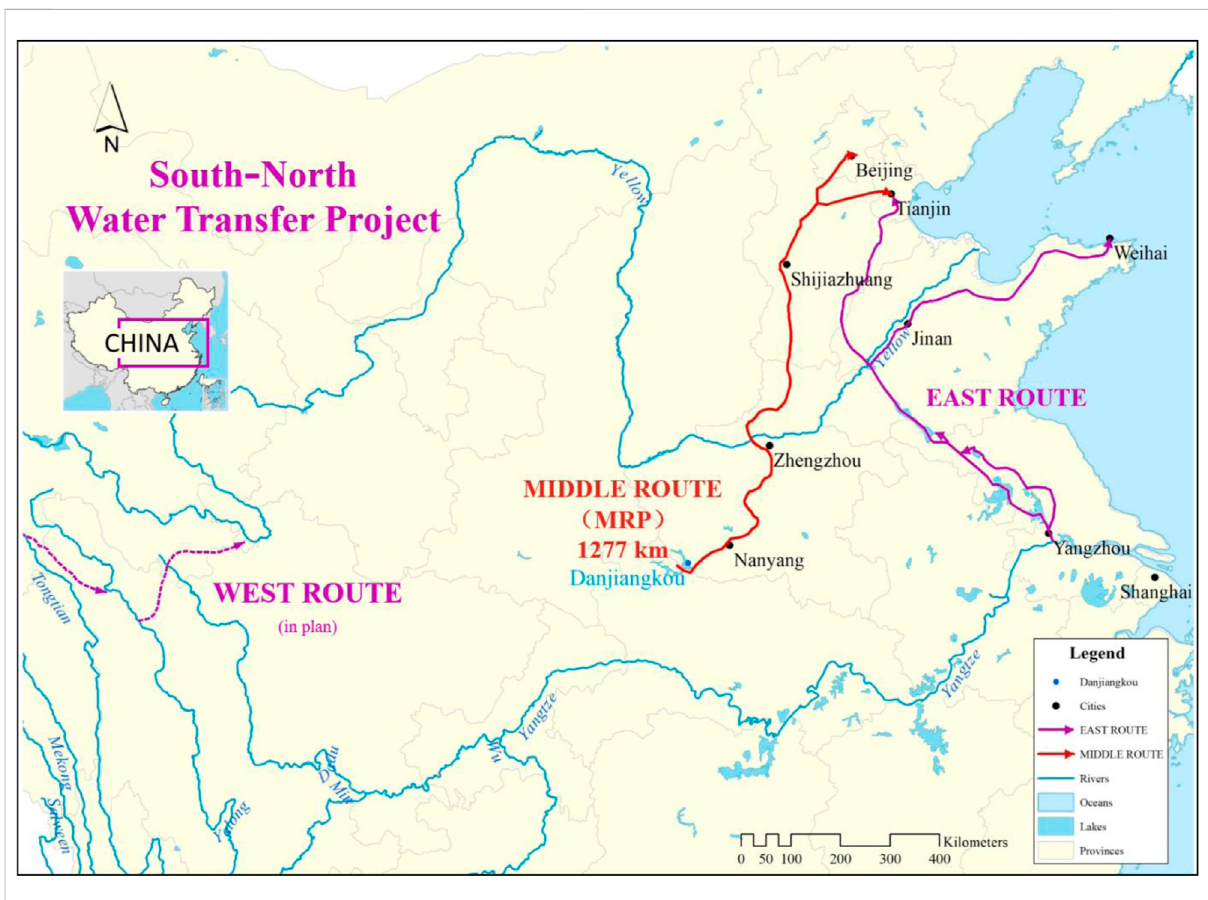
FIGURE 1 The eastern, middle and western route of the South-to-North Water Diversion